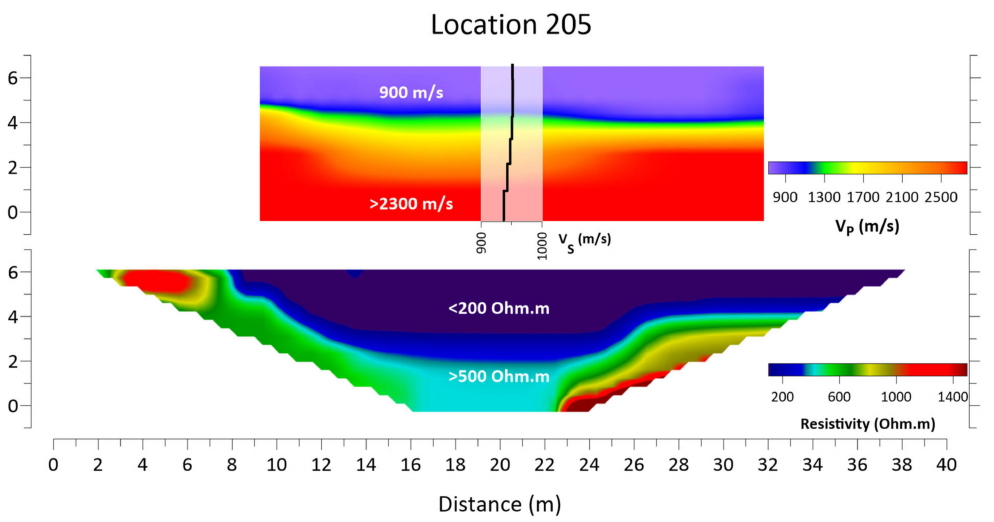
Figure 8. SRT and MASW ( top ) and ERT ( bottom ) at location 205, investigating the Pantocrator limestone ( Ji.k